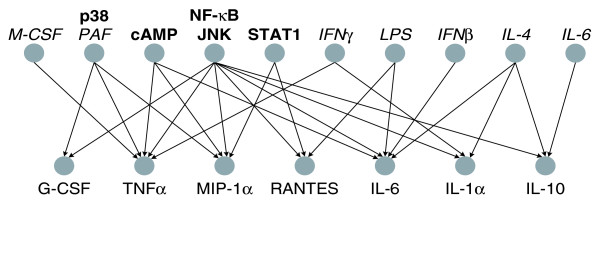
Combined network of signaling components required for the production of cytokines. Upper row represents the different signaling pathway components. Lower row represents the different cytokines. Bold face: signaling component identified from measured signaling pathways. Italic face: signaling component identified from residuals and representing ligand-specific unmeasured pathways.